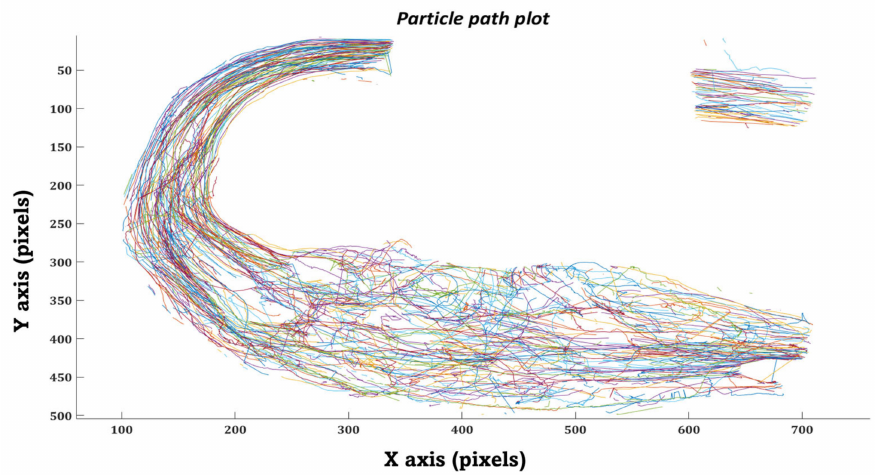
Figure 29. Trajectory plot of the tracked particles in the MPA conduit for patient